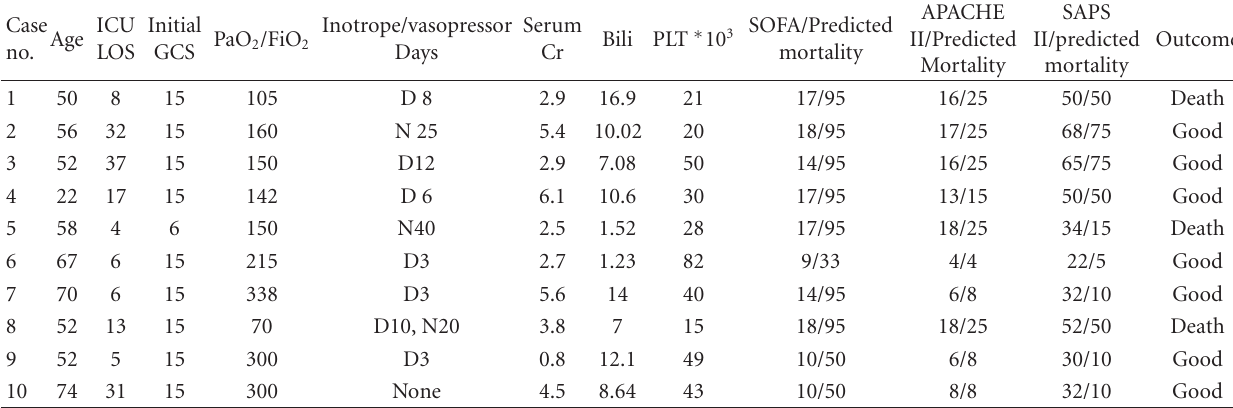
Table 2: Demographic and clinical data for each patient.